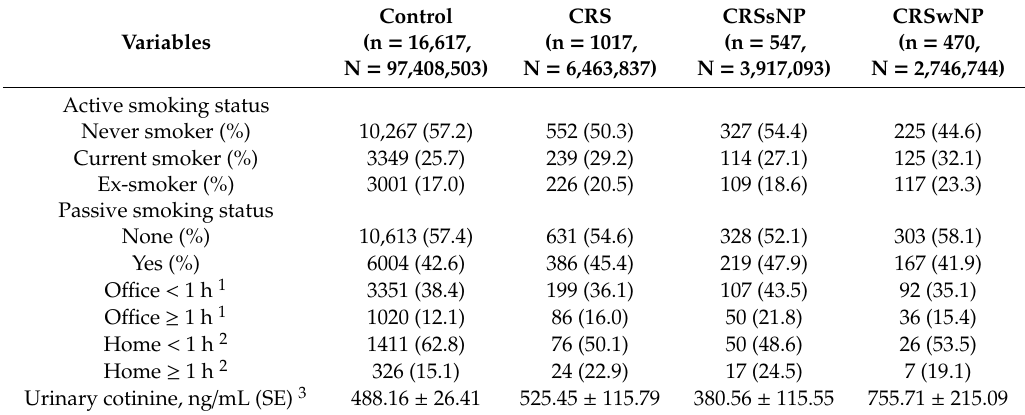
Table 1. Status of cigarette exposure-related factors in the control and the chronic rhinosinusitis